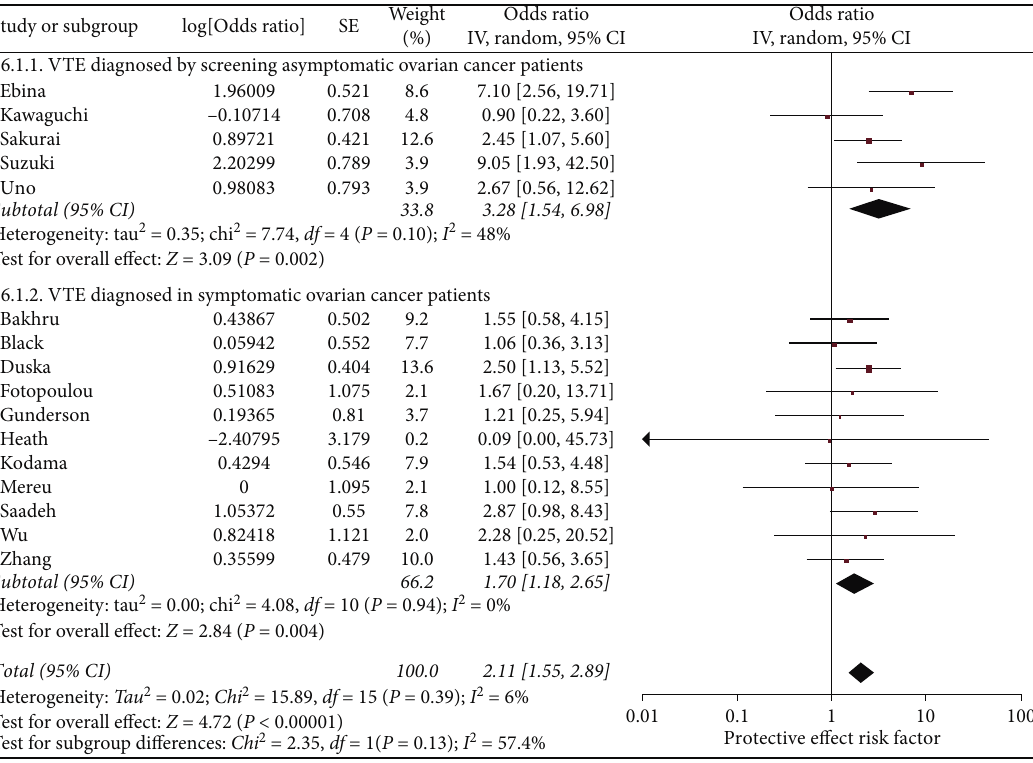
Figure 4: Forest plot of the odds of VTE in ovarian cancer patients that have clear cell carcinoma histology (versus nonclear cell carcinoma). This figure shows the pooled odd of clear cell carcinoma histology (versus nonclear cell carcinoma). The total pooled odds are 2.11